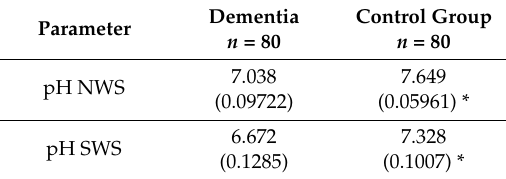
Table 3. Salivary